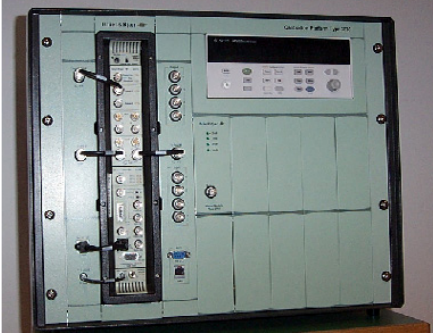
Fig. 18. Main unit of the B&K SLM calibration system that depending on the type of SLM works fully automated, semi-automated or